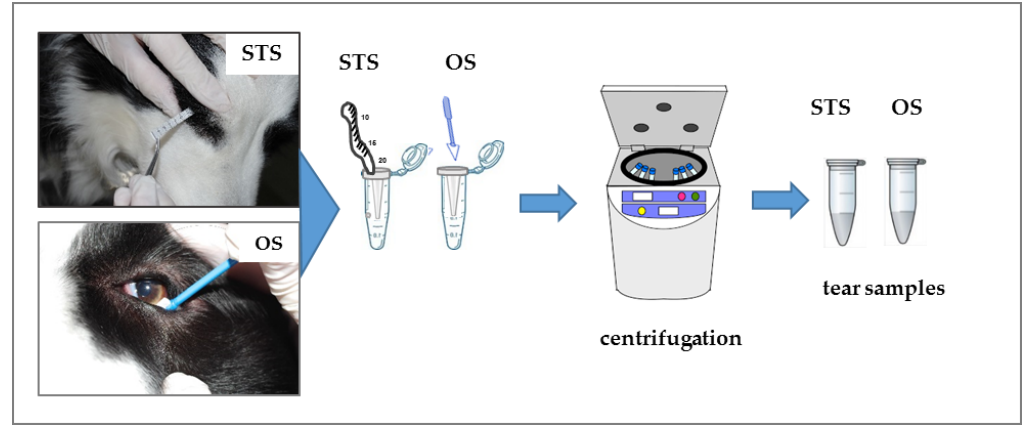
Figure 1. Phases of the experimental procedure for dog tear collection. STS: Schirmer tear strips, OS: ophthalmic sponges.